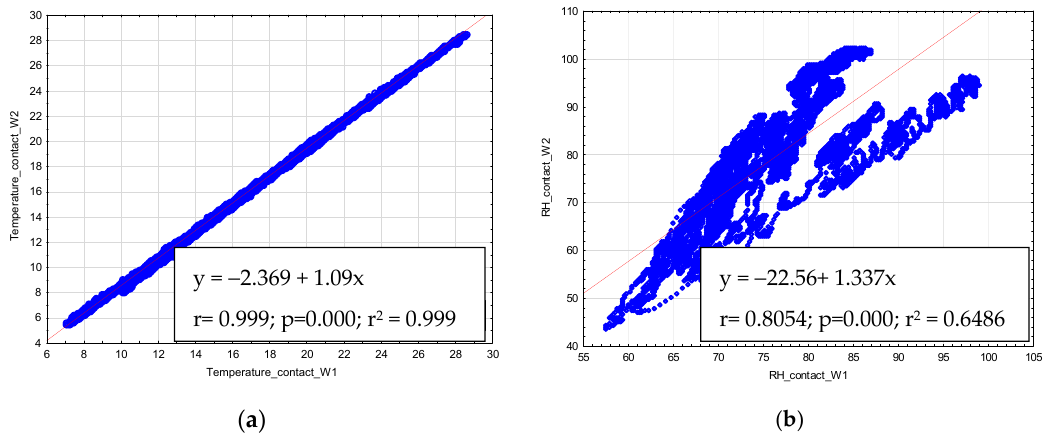
Figure 16. Scatter diagram of temperature ( a ) and humidity ( b ) for variant W1 against variant W2. It should be noted that the applied recycling panels (W_1) were characterized by a worse thermal conductivity coefficient than the lightweight cellular concrete panels (W_2). Moreover, the entire insulated wall was characterized by a higher thermal trans- mittance coefficient U [W/m 2 K]. For the wall in the first variant, W_2, the value of the coefficient was 0.25 [W/(m 2 K)], and for the wall W_1 insulated with the recycling panels, U = 0.39 [W/(m 2 K)] (Figures 17 and 18).